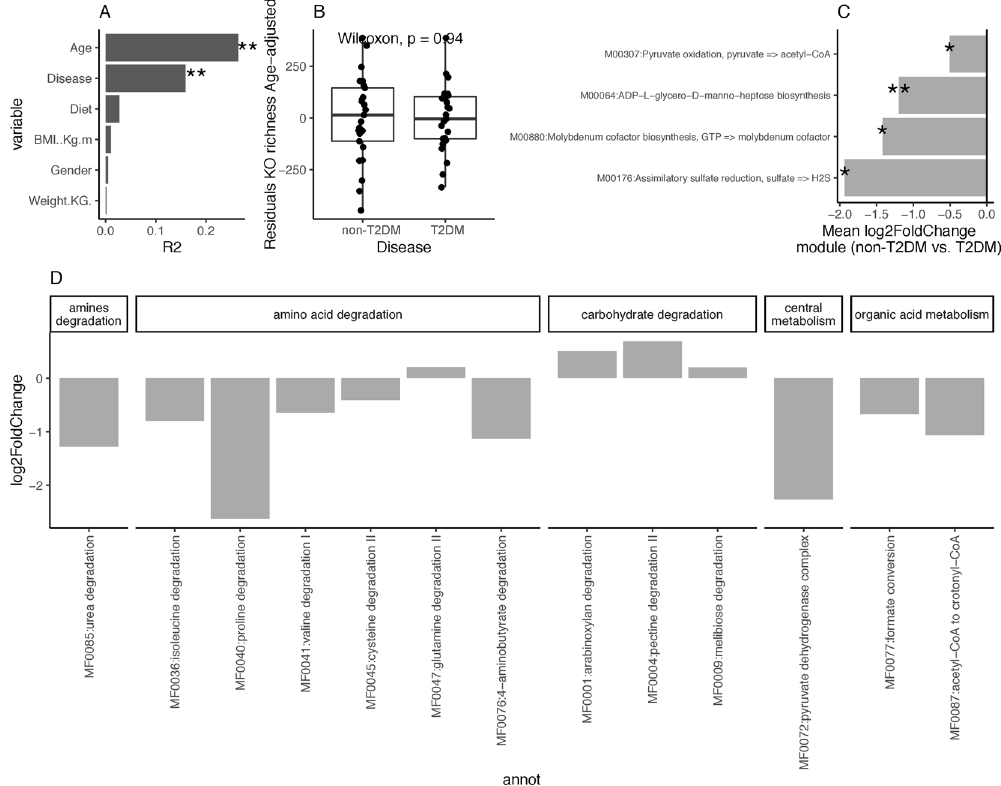
Figure 3. Functional profiling based on PICRUS analyses of 16 S data. ( A ) Effect sizes of clinical covariates and disease state over functional diversity distribution (KEGG orthology (KO) groups identified in PICRUSt analyses) based on linear regression analyses ( ** = FDR < 0.05; * = P value < 0.05, FDR > 0.05). ( B ) Differences in residuals of linear-regression between functional diversity (Observed KOs, dependent variable) and age (independent variable) between study groups. ( C ) KEGG modules significantly enriched in differentially abundant KO groups between non-T2DM and T2DM group ( ** FDR < 0.05, * = P value < 0.05; Gene Set Enrichment Analyses). The mean log2 fold changes of module KOs abundances between non-T2DM controls and T2DM is represented as indicator of enrichment direction (all modules enriched in the T2DM group; mean log2 fold changes non-T2DM controls vs. T2DM < 0). ( D ) Bar plot of log2 fold changes in Gut metabolic modules (GMMs) abundances between health controls and T2DM (P value < 0.05 in GLM model with negative binomial distribution of GMM abundance by disease state adjusted by